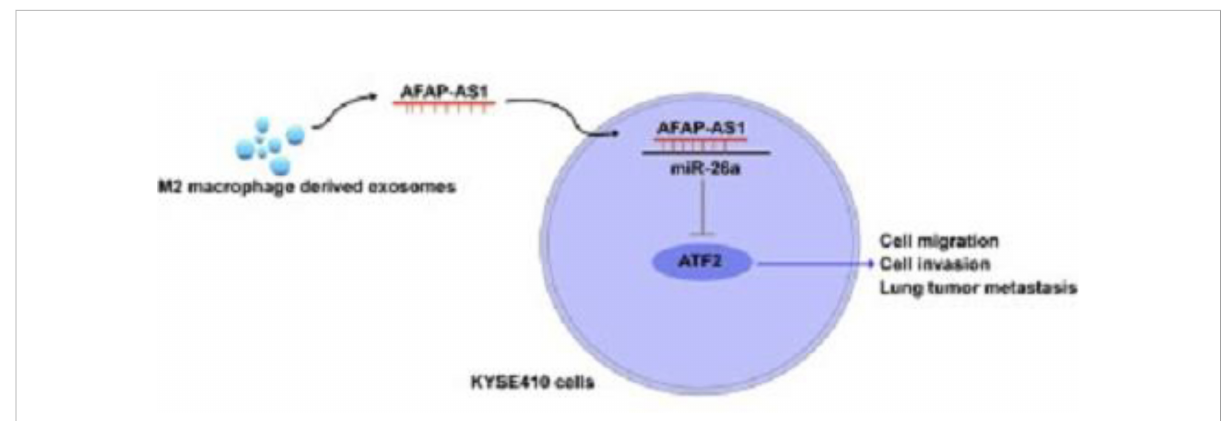
FIGURE 5 The M2 macrophage-derived exosomal lncRNA AFAP1-AS1 enhances the migration and invasion of EC cells and tumor metastasis through the AFAP1-AS1/miR-26a/ATF2 axis. Exosomes from immune or cancer cells can transport bio-macromolecules or lncRNAs to affect the development or progression of tumors by altering the microenvironment. ATF2 was a direct target of miR-26a, and lncRNA AFAP1-AS1 could selectively sponge miR-26a to reduce its expression. Exosomes produced by M2 macrophages had reduced miR-26a expression and greater AFAP1-AS1 and ATF2 expression. Additionally, extracellular AFAP1-AS1 might be transferred to KYSE410 cells by combining with exosomes produced by M2 macrophages. Through the high expression of AFAP1-AS1, M2 macrophage-derived exosomes may downregulate miR-26a and enhance the expression of ATF2, allowing EC cells to migrate, invade, and metastasize; M2-exosomes that increased AFAP1-AS1 or decreased miR-26a attenuated this effect. This fi gure was adapted from Mi et al.